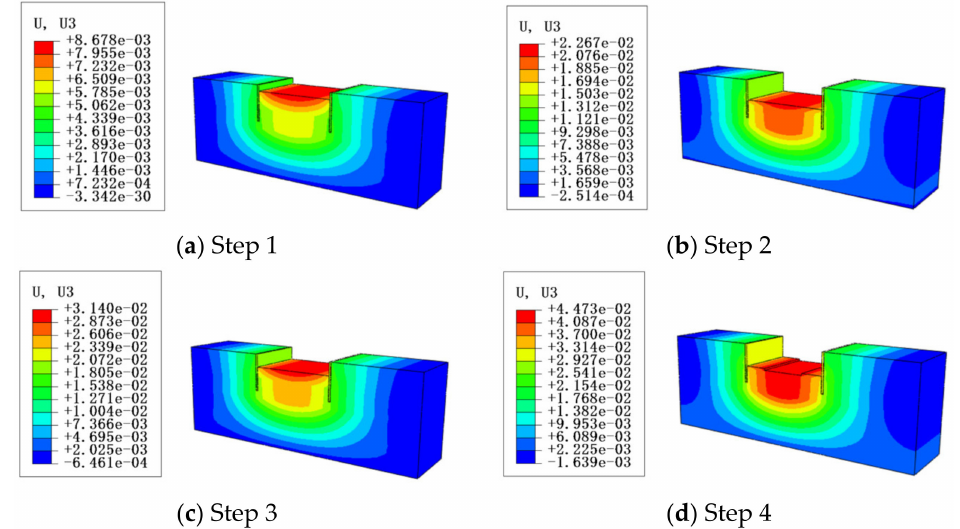
Figure 9. Vertical